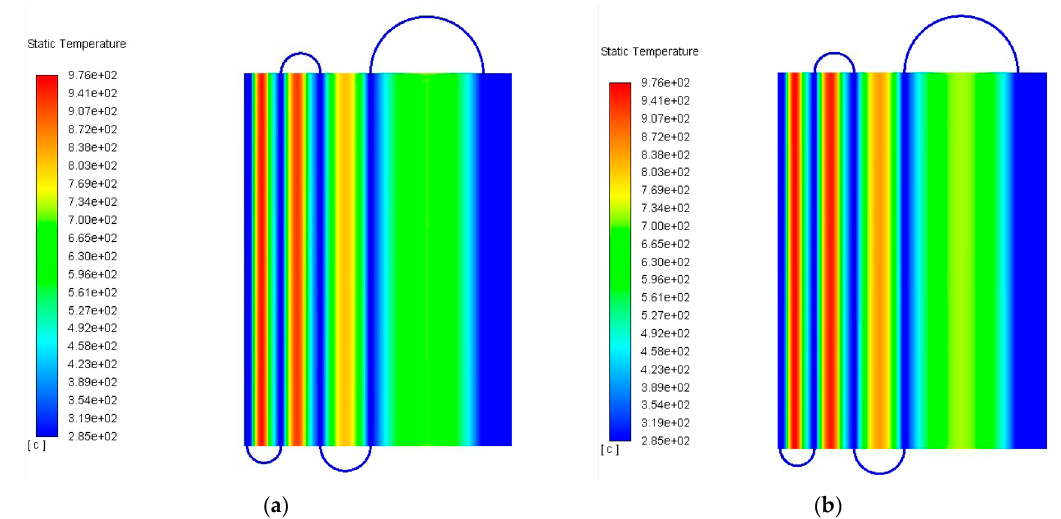
Figure 21. Temperature distribution in the WCCB blanket: ( a ) one-way N/TH coupling calculation; ( b ) two-way N/TH coupling calculation.